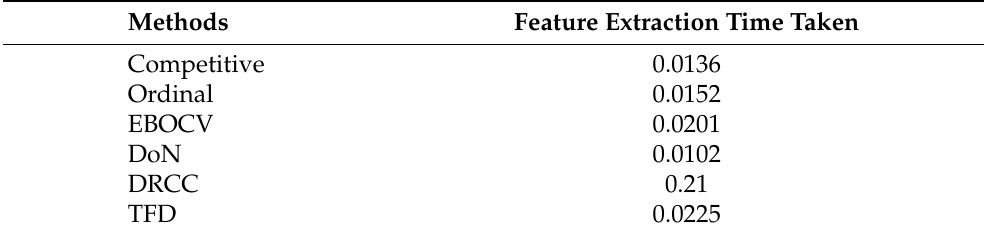
Table 2. The average time taken (in second) of different methods for extracting the features of a palmprint